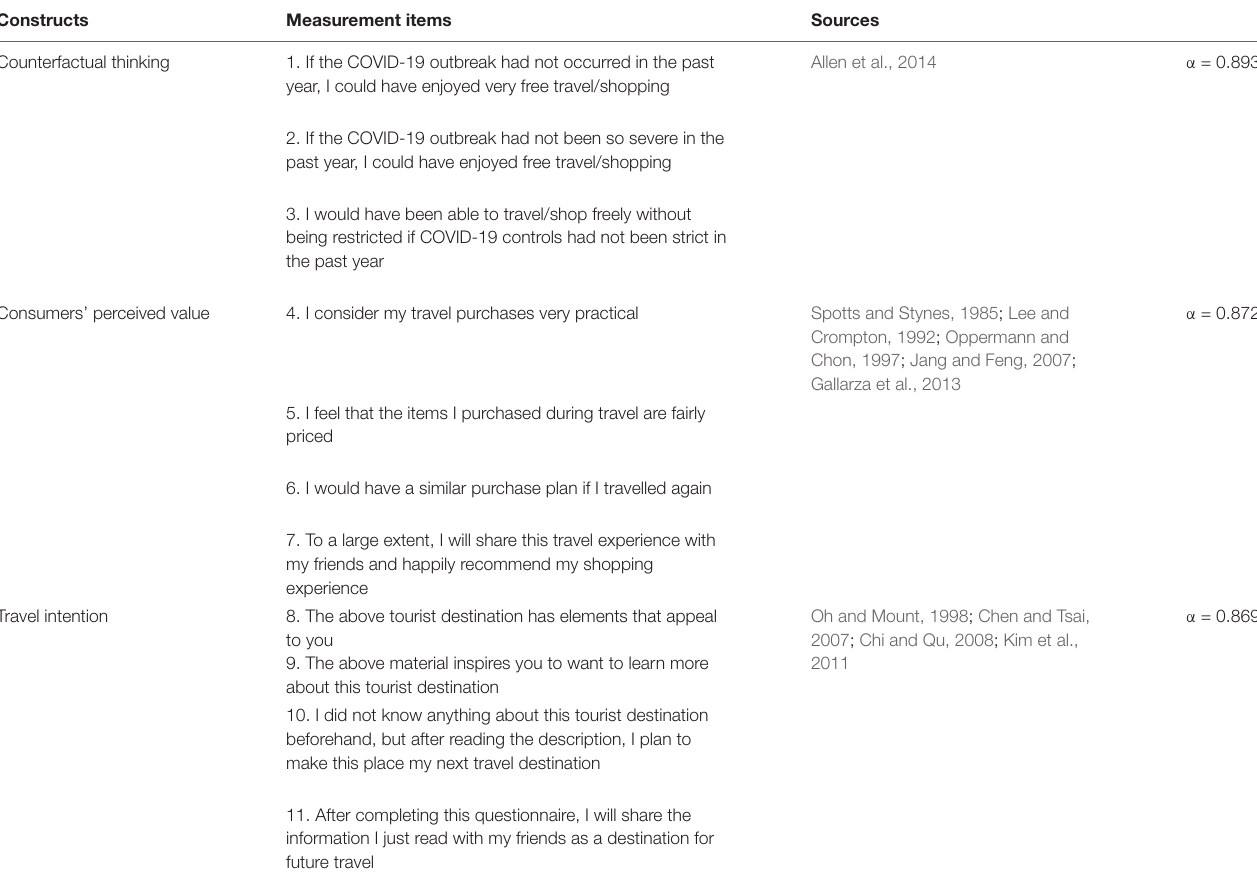
TABLE 1 | Measurement items and